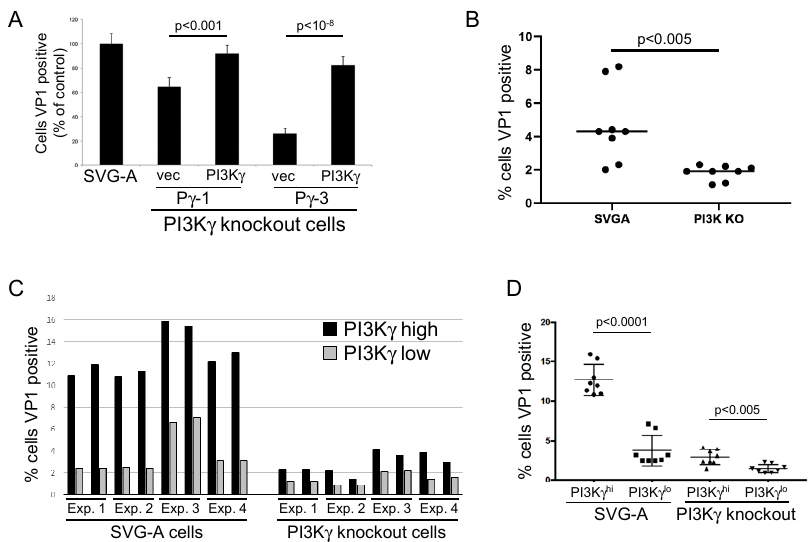
Figure 3. PI3K γ expression rescues JC polyomavirus infection defect caused by PI3K γ knockout. ( A ). PI3K γ knockout SVG-A cells were infected with LEX-PI3K γ or empty LEX vector (vec) lentivirus and selected in medium containing puromycin. Puromycin-resistant cells were infected with JCPyV. Three days later, cells were immunostained for intracellular VP1. Graph shows average fraction of cells that expressed VP1, as assessed by Cell Profiler, normalized to infected parental SVG-A cells, plus and minus standard error. Infectivity of cells with transduced PI3K γ was statistically significantly higher than cells transduced with empty vector as assessed by 2-tailed t-test with equal variance. In a typical experiment, ~1% of infected control cells were VP1 + . ( B ). Parental SVG-A cells and PI3K γ knockout cells (clone P γ -3) were transduced with empty LEX lentivirus and selected in puromycin. Pooled puromycin-resistant cells were infected with JCPyV virus. Cells were fixed and immunostained for intracellular VP1 three days later, and VP1 expression was analyzed by flow cytometry. Graph shows fraction of cells that expressed VP1. Results are aggregated data from four independent experiments, each performed in duplicate. Representative primary data are shown in Figure S3. ( C ). Parental SVG-A cells and PI3K γ knockout cells (clone P γ -3) were infected in duplicate with LEX-PI3K γ vector lentivirus and selected in puromycin. Pooled puromycin-resistant cells were infected with JCPyV, stained for intracellular VP1 and PI3K γ three days later, and assessed by flow cytometry. Graph shows the percentage of cells expressing VP1 after infection with JCPyV in PI3K γ hi (black bars) and PI3K γ lo (grey bars) cell populations. ( D ). The graph shows the percentage of cells expressing VP1 after infection with JC polyomavirus (JCPyV) as in panel C in the PI3K γ hi and PI3K γ lo populations, plus and minus standard deviation. Each point represents an individual determination. For panels B , C , and D , representative primary data are shown in Figure S3. Data and standard deviation intervals are tabulated in Table 1.